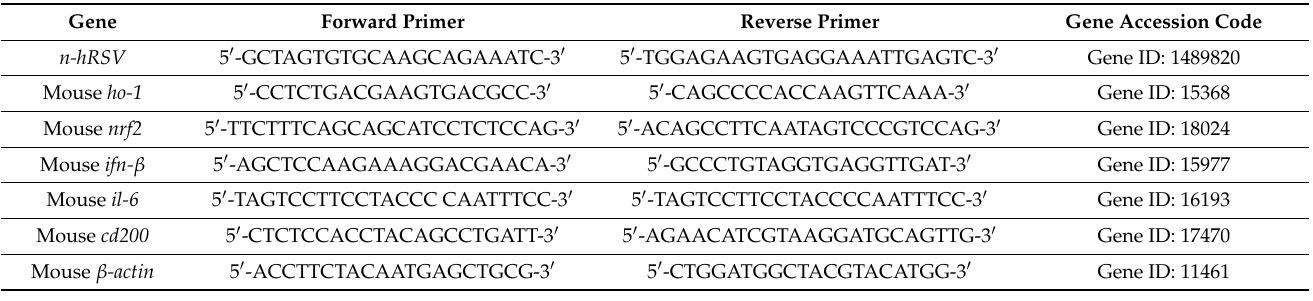
Table 2. List of primers used for real-time quantitative reverse transcription polymerase chain reaction (RT-qPCR) analysis.